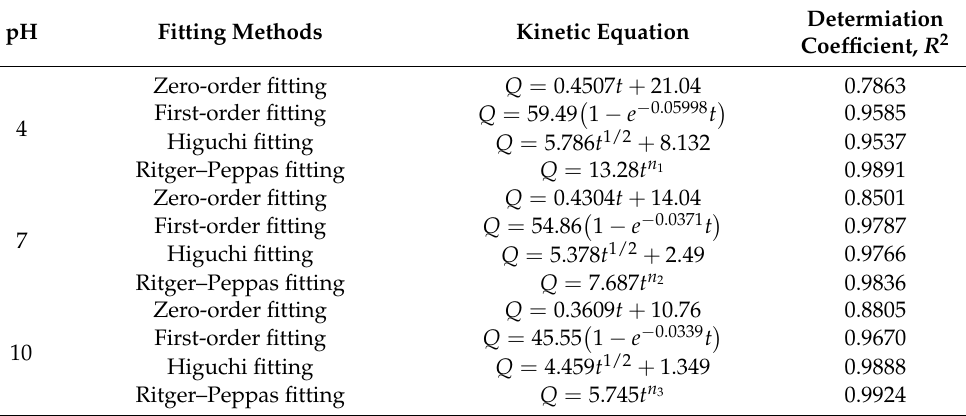
Figure A1. 13 C NMR spectrum of MPTES-SS-Py in dideuteromethylenechloride (CD 2 C l2 ). Table A1. Release parameters of Pro@BMMs-SS-Py/ β -CD NPs at different pH